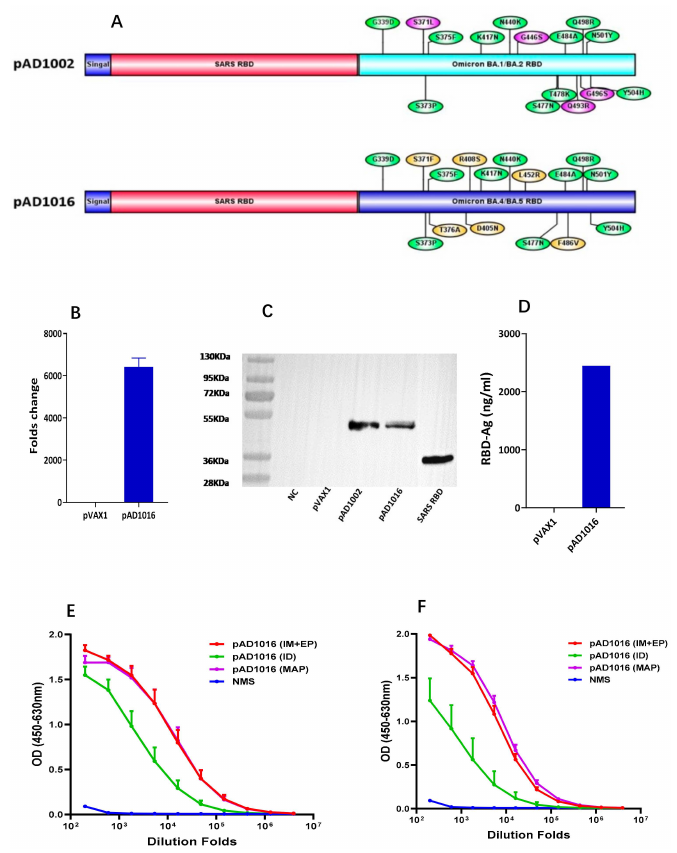
Figure 1. Construction of pAD1016. ( A ) Schematic diagram comparing the primary structure of se- creted polypeptides encoded by pVAX1-based vaccine candidates pAD1002 and pAD1016. ( B ) qPCR detection of RBD mRNA transcripts in HEK293T cells transiently transfected with pVAX1 or pAD1016. ( C ) Samples of HEK293T cells transiently transfected with, or without (NC), pVAX-1, pAD1002 or pAD1016 were run SDS-PAGE gel followed by Western blotting using anti-RBD SARS Abs for de- tection. Recombinant RBD SARS was included as control. ( D ) Secreted recombinant heterodimeric RBD polypeptide in culture supernatant of the transfectant HEK293T cells was quantitated using anti-RBD SARS Ab-based sandwich ELISA. HRP-labeled anti-RBDWT Ab was employed as detection Ab. Serum samples, collected from BALB/c ( E ) and C57BL/6 ( F ) mice after secondary immuniza- tion with 20 µ g pAD1016 DNA via MAP-1016 administration (MAP), intradermal injection (ID) or intramuscular inoculation followed by EP (IM+EP), were titrated against recombinant RBD WT in ELISAs. Normal mouse serum (NMS) was included as negative control. Data represent mean ± SD ( n = 5 biologically independent samples). The original whole blot and the densitometry readings of the bands in WB shown in Supplementary Figure